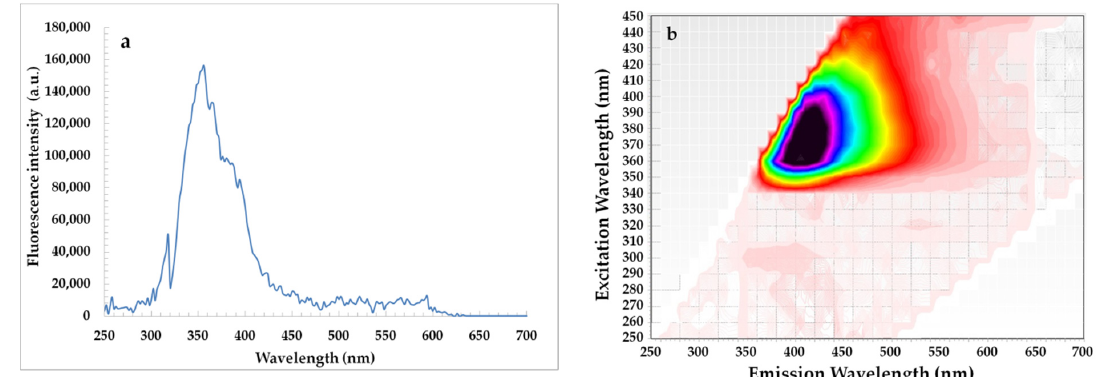
Figure 4. Synchronous fluorescence spectrum recorded at ∆ λ = 30 nm ( a ) and excitation-emission matrix ( b ) of β -sitosteryl sinapate diluted in n -hexane (c =